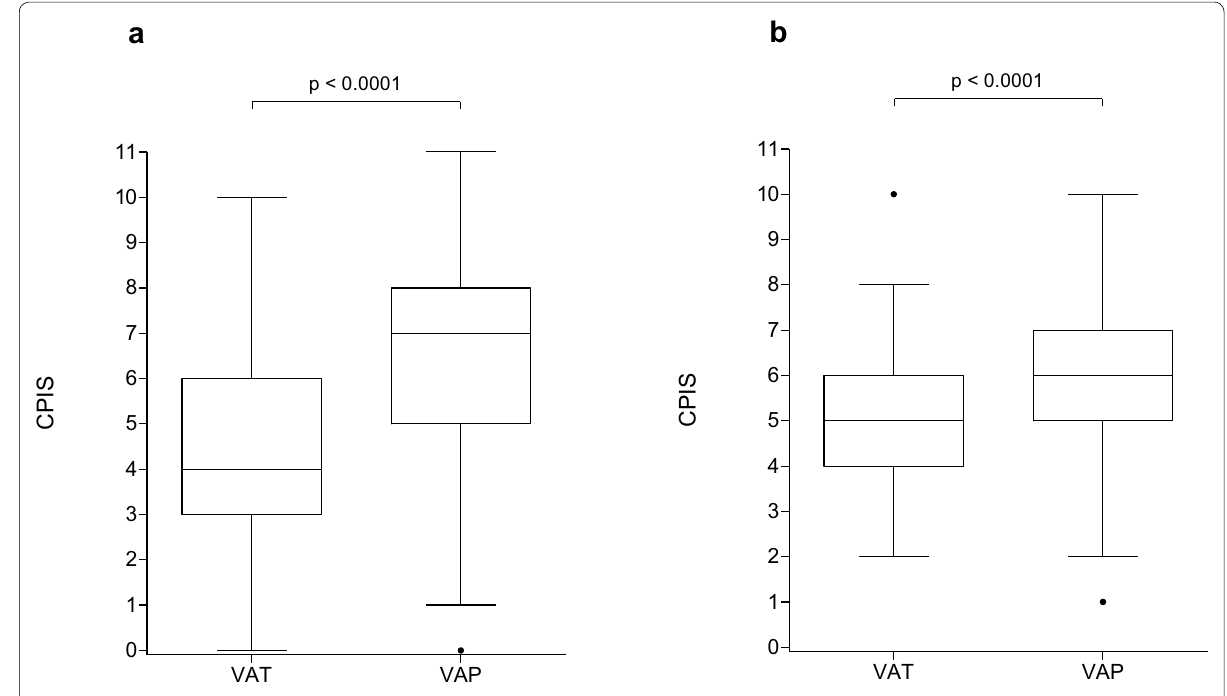
Fig. 1 Values of CPIS in patients with VAT and VAP in the derivation ( a ) and validation ( b ) cohorts. Box plot shows the median (horizontal line) and IQR (25th 75th percentile) (box). The whiskers show the lowest data within 1.5 IQR of the lower quartile and highest data within 1.5 IQR of the upper quartile. Data outside 1.5 IQR of the upper or lower quartiles are depicted with a dot. CPIS Clinical Pulmonary Infection Score; VAP Ventilator‑Associated Pneumonia; VAT Ventilator‑Associated Tracheobronchitis